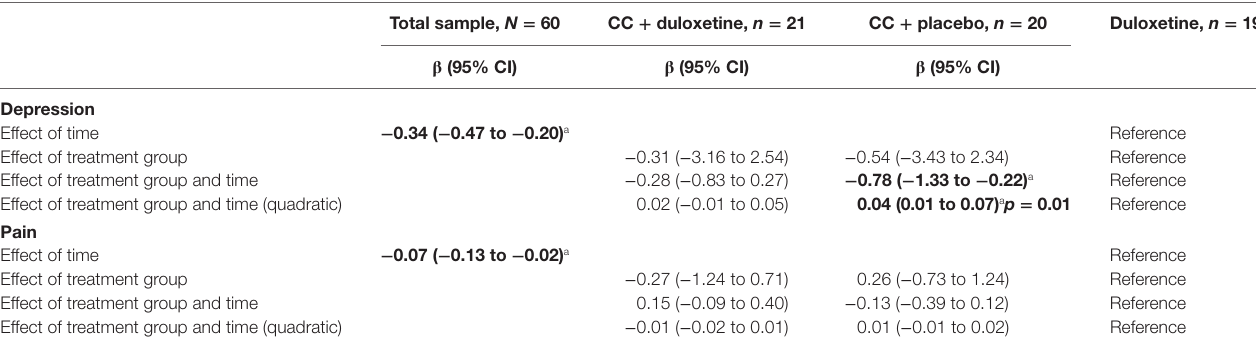
TaBlE 3 | Intention-to-treat, multilevel analyses comparing the CC + duloxetine and CC + placebo treatment groups with the duloxetine alone treatment group for depressive and pain symptoms.